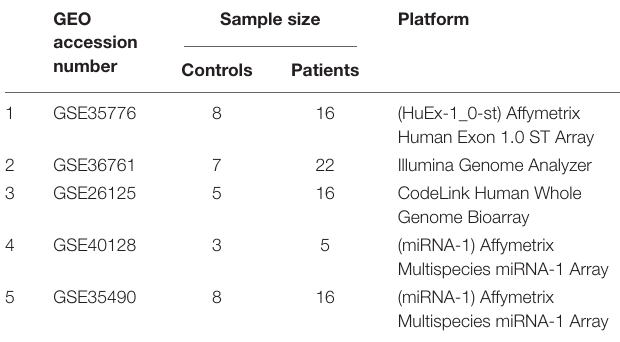
GEO, Gene Expression Omnibus